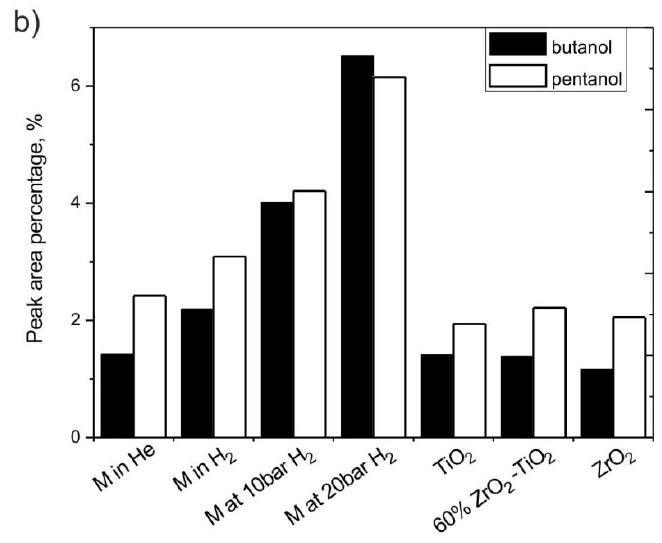
Figure 10. ( a ) The peak area percentages of furans; ( b ) The peak area percentages of alcohols.